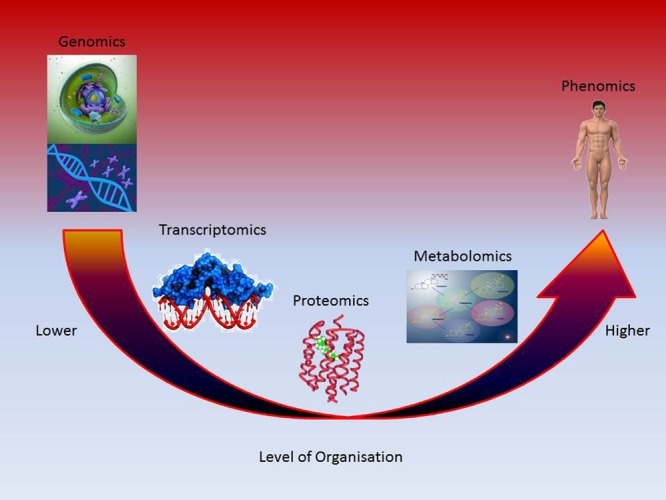
Metabolic profiling reflects the collective effects of lower levels of organization.